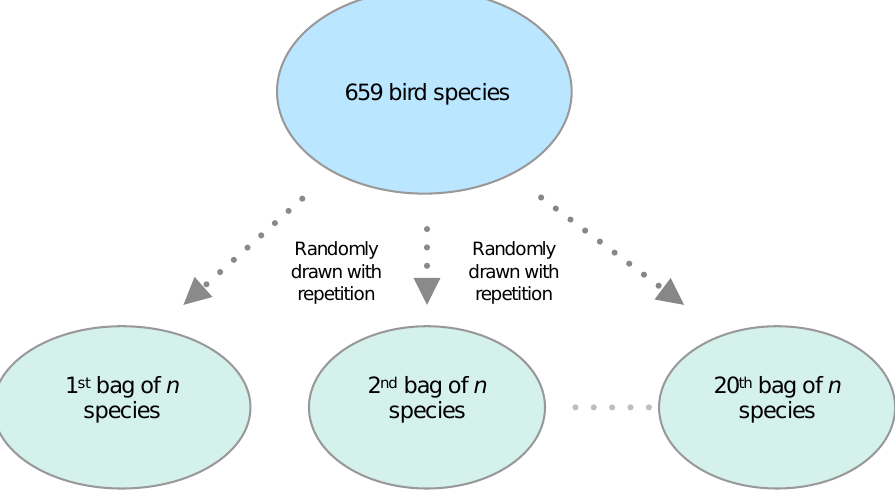
Figure 1. Schematic for the bags-of-birds